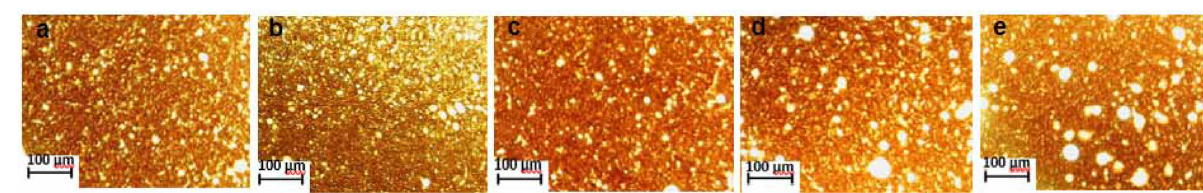
Figure 7. Effect of salt type on mean droplet size ( a ) MgCl 2 , ( b ) CaCl 2 , ( c ) MgSO 2 , ( d ) Na 2 SO 4 , ( e ) NaCl at 10,000